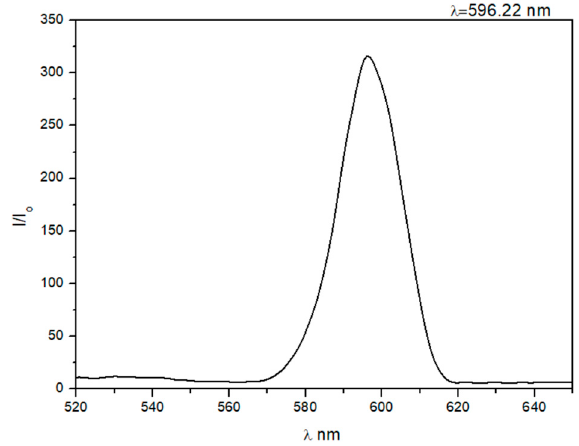
Figure 2. PL of In 0.1 Ga 0.9 N thin film.